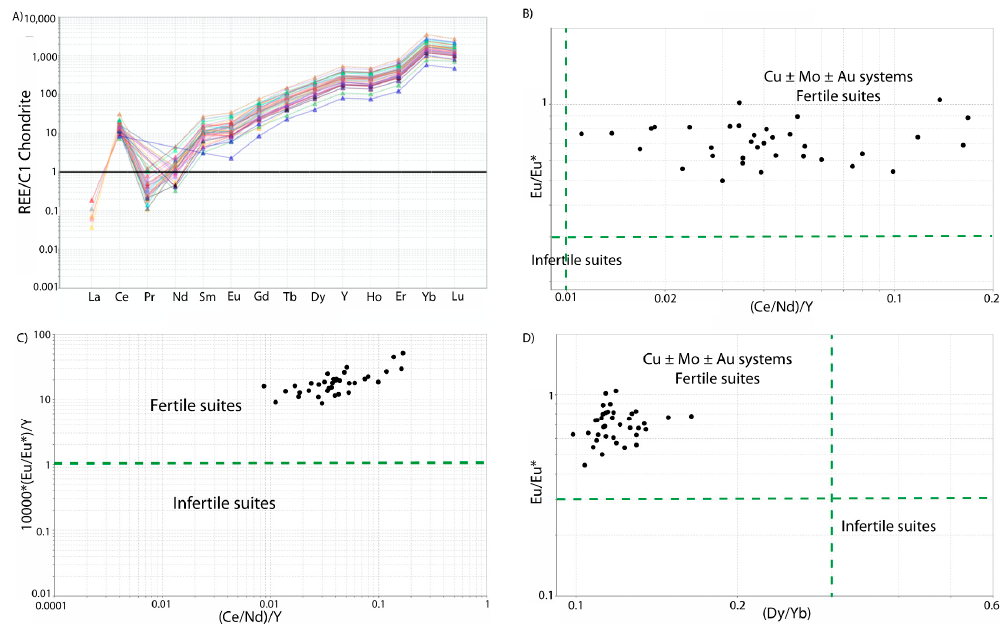
Figure 12. Zircon geochemistry. ( A ) C1 chondrite-normalized rare earth elements (REE) patterns of zircon from Mollehuaca; normalization values of Sun and McDonough (1989); ( B ) Zircon Eu / Eu * vs. (Ce / Nd) / Y plot. Mollehuaca zircon Eu / Eu * values ( > 0.44) and (Ce / Nd) / Y ratios ( > 0.01); ( C ) Zircon 10,000*(Eu / Eu *) / Y vs. (Ce / Nd) / Y plot; ( D ) Zircon Eu / Eu * vs. Dy / Yb plot, showing that the fertile suites from Mollehuaca have low Dy / Yb ( < 0.23) ratios.